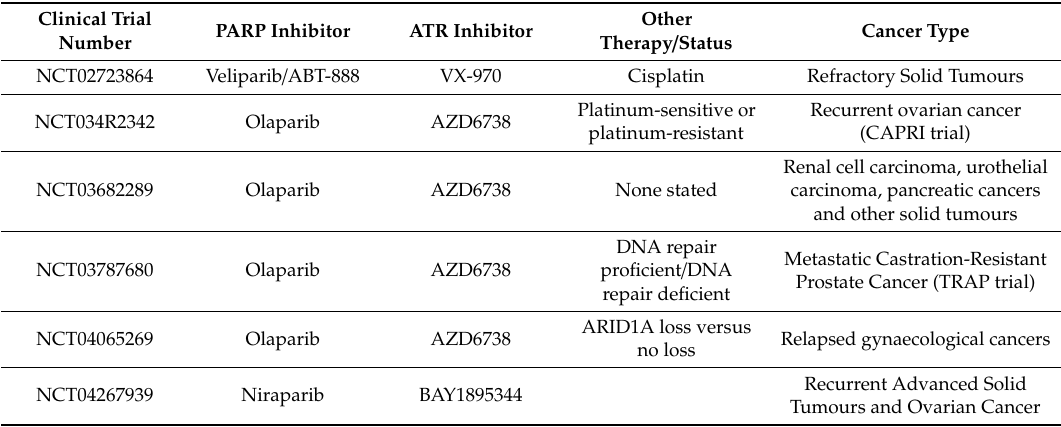
Table 1. List of ongoing clinical trials combining a poly-ADP ribose polymerase (PARP) inhibitor with an ATR inhibitor. Information obtained from https: // clinicaltrials.gov, accessed March 9